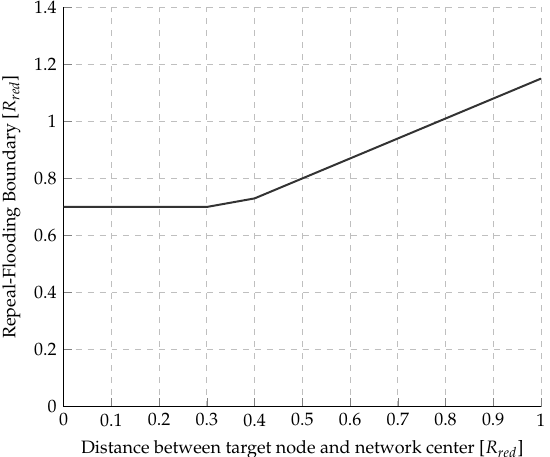
Figure 5. Repeal-flooding boundary versus target node’s distance to the network’s